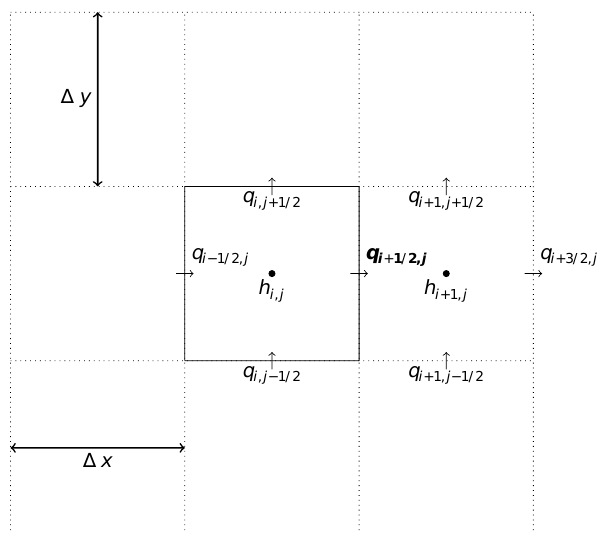
Figure 2. A 2-D view of the staggered grid used by the numerical scheme. The variable in bold will be calculated at t + (cid:49)t using all the displayed variable values at time t